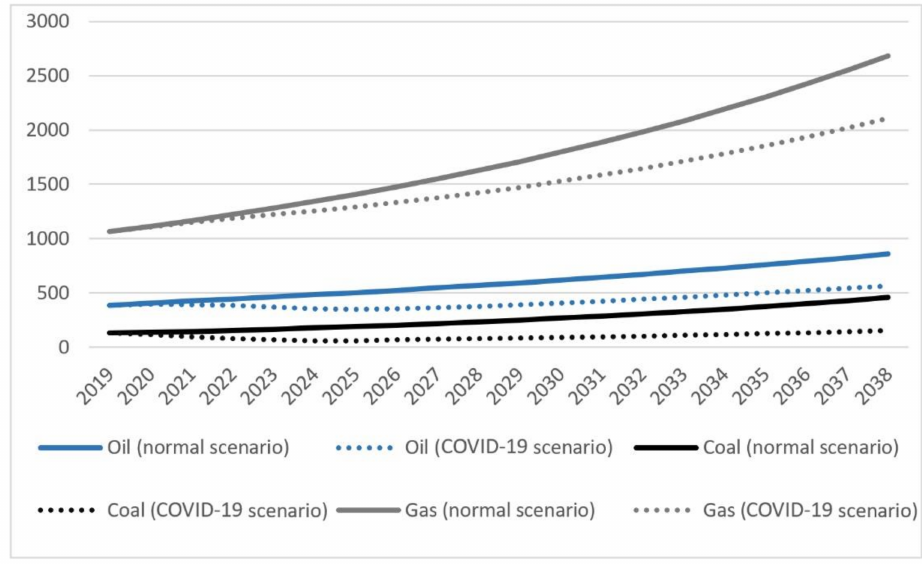
Figure 8. Forecast oil, coal, and gas demand